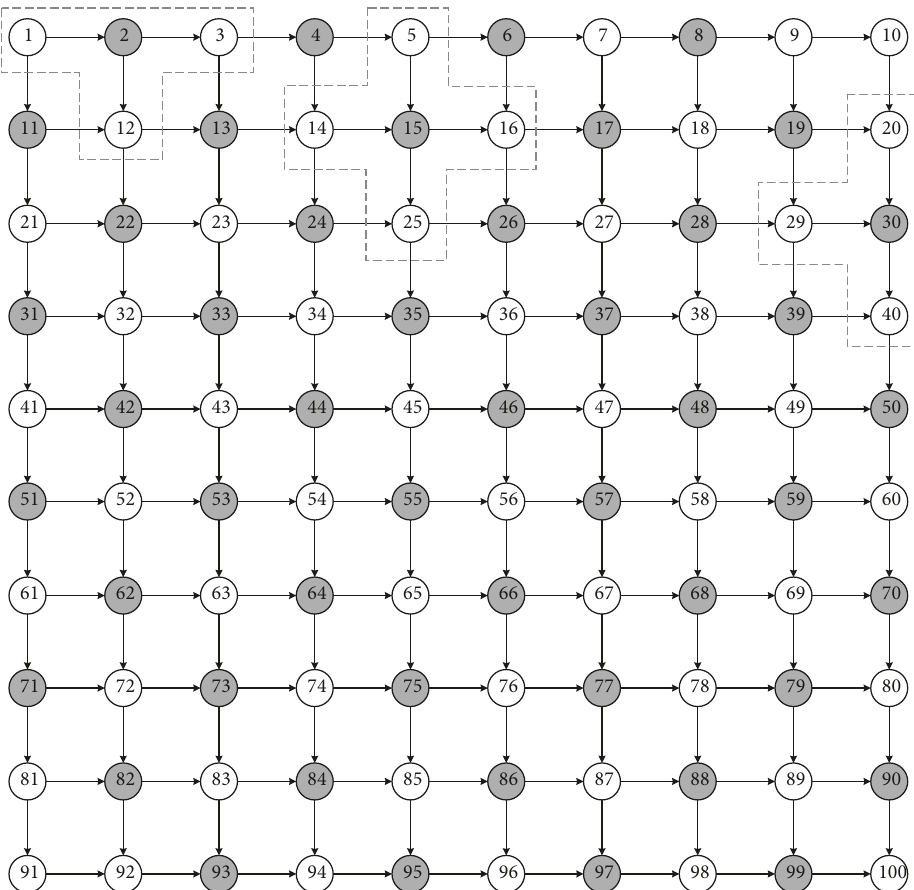
Figure 8: The simulation of real-time traffic network.